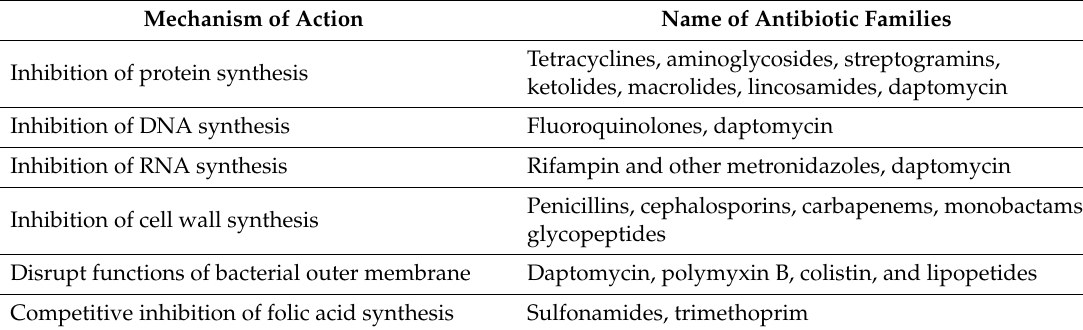
Table 2. Mechanism of action of